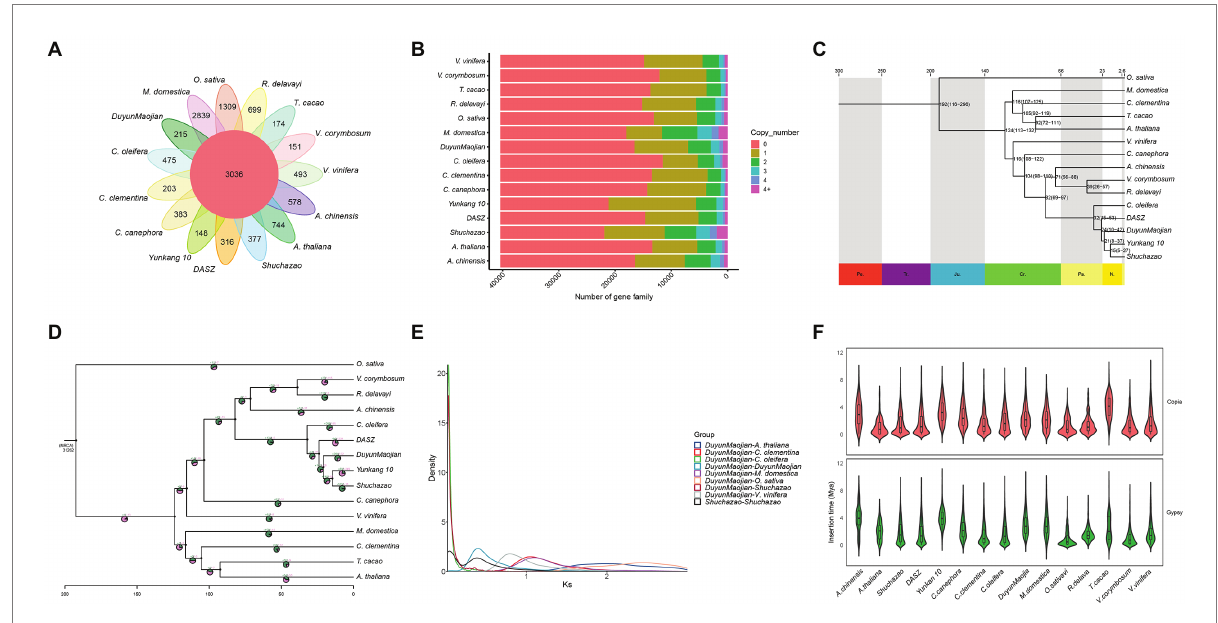
FIGURE 4 Comparative genomic analysis. (A) . A Venn diagram shows the shared and unique gene families among the DuyunMaojian and 14 other species. (B) . The copy number distribution of the DuyunMaojian tea plant and other 14 species. (C) . Phylogenetic tree of the DuyunMaojian tea plant and other 14 species. (D) . Expansion and contraction of gene families among the 15 plant species. (E) . Whole genome duplication events detected in the DuyunMaojian tea plant. (F) . Insertion times of copia and gypsy.